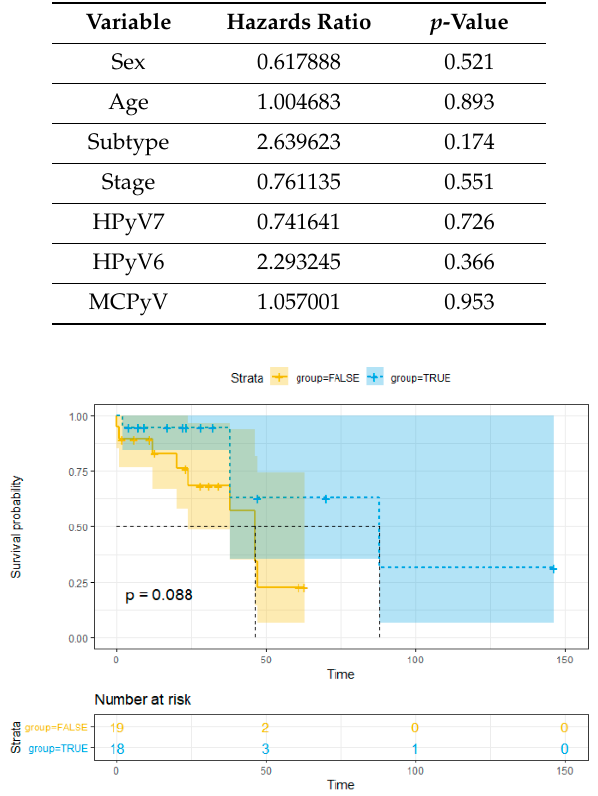
Table 3. Cox regression model for multivariable analysis of iCCA and pCCA cohort.